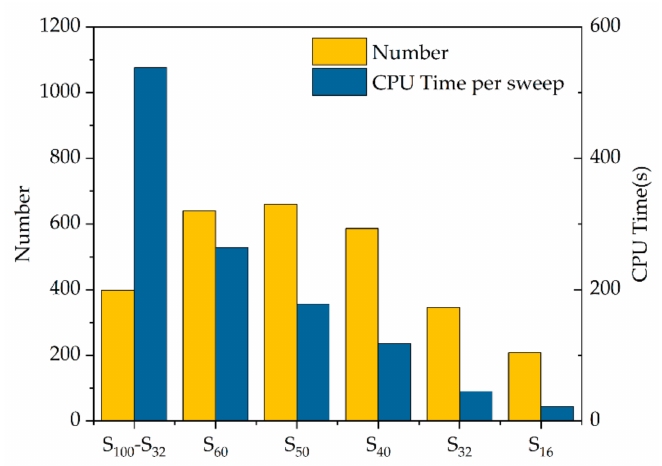
Figure 11. The number of times the quadrature is used for the IRI-TUB